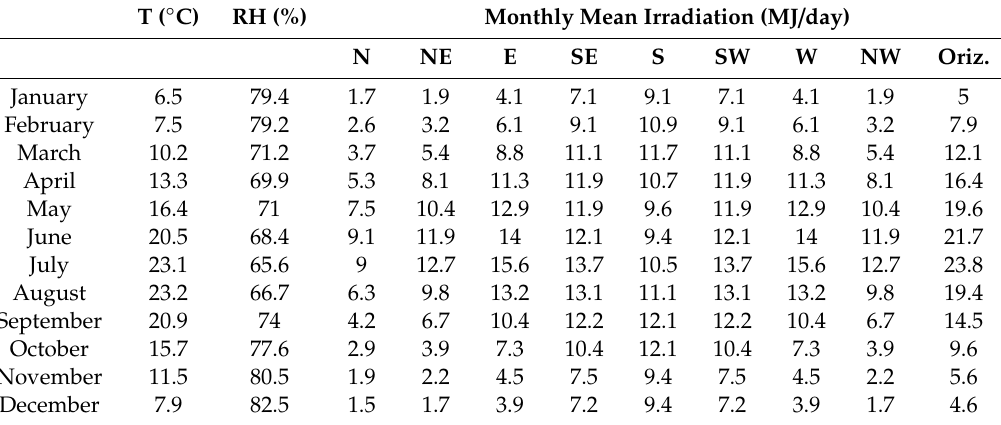
Table 4. Climatic data: solar irradiation.